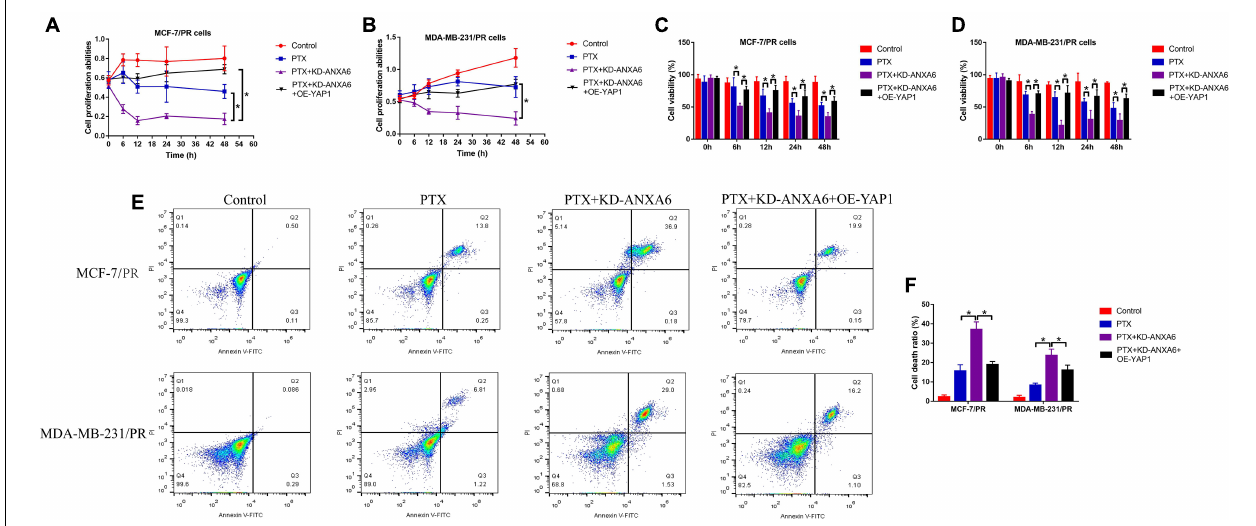
FIGURE 6 | ANXA6 knockdown promoted PTX sensitivity in PR-BC cells via modulating YAP1. (A,B) MTT assay was used to detect cell proliferation. (C,D) Trypan blue staining assay was conducted to measure cell viability. (E,F) Cell death ratio was determined by performing FCM assay. A single experiment had three repetitions, and * p < 0.05 was regarded as statistical